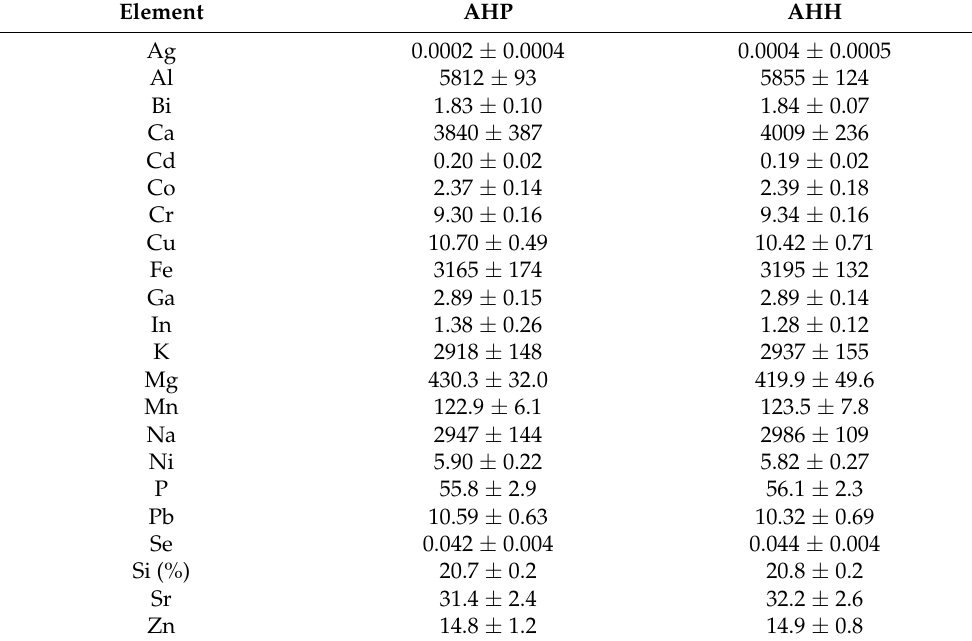
Table 11. Concentrations of some elements (mg/100 g d.s.) * in soil samples, representative of the growing soil trees for the two varieties of A. hippocastanum (AHP and AHH). Data collected in the year